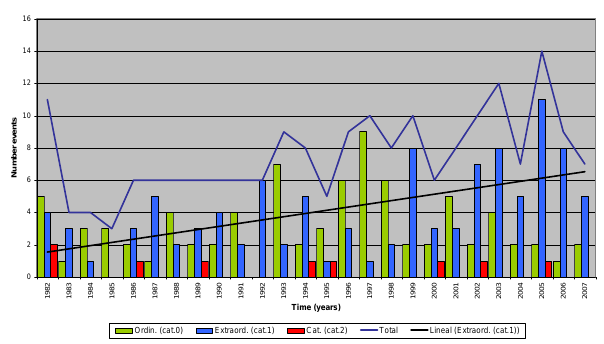
Figure 9. Distribution of flood events by categories and annual evolution over the Fig. 9. Distribution of flood events by categories and annual evolu- period 1982-2007 tion over the period 1982–2007.